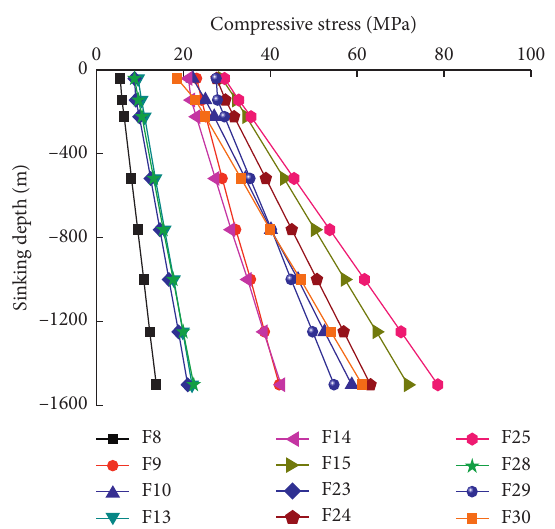
Figure 9: Theoretical stress curves of the lower supporting bars under different working